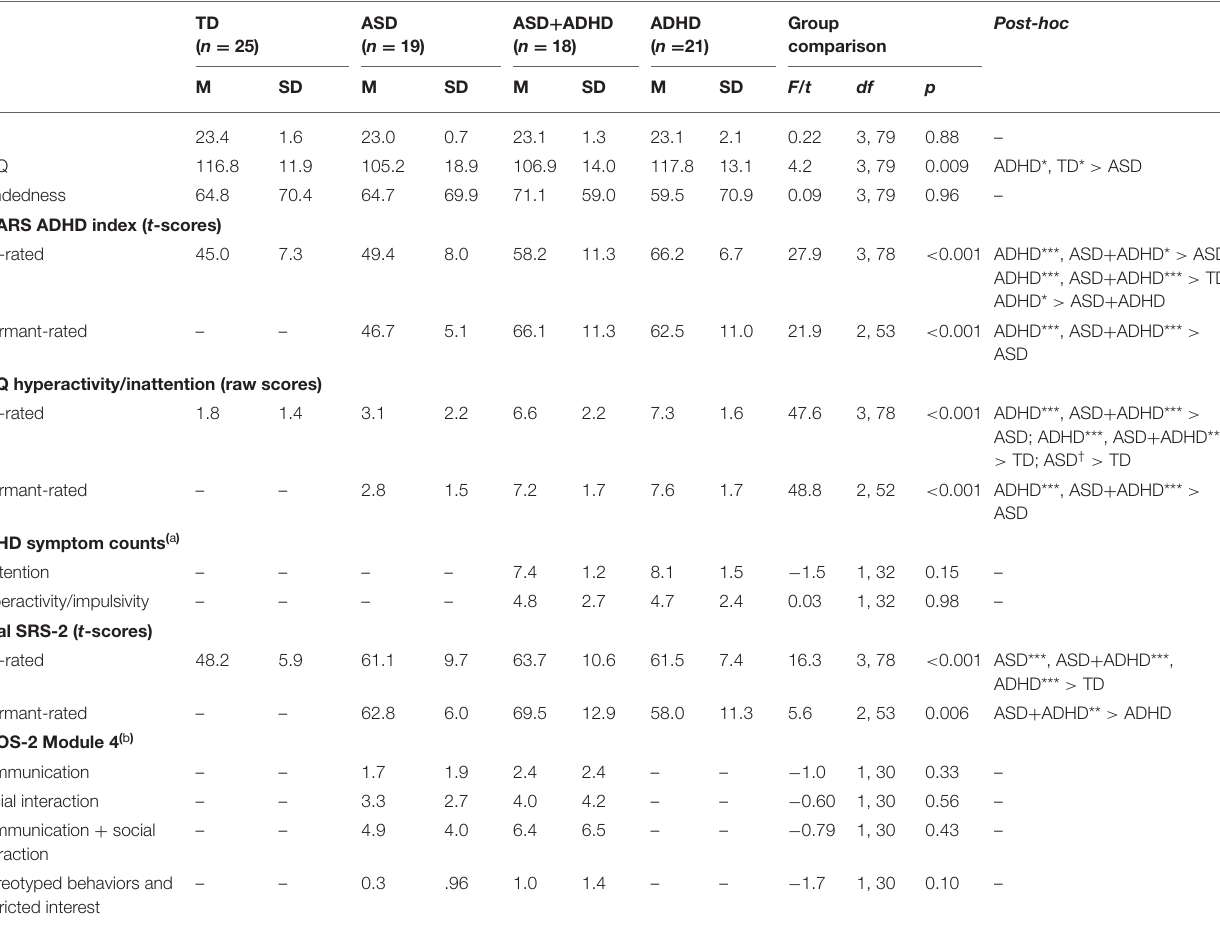
TABLE 1 | Group differences in socio-demographic variables and clinical measures.